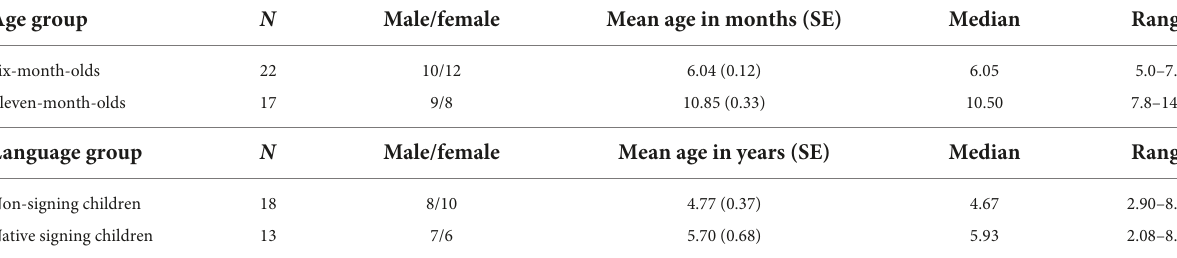
TABLE 1 Demographics of study